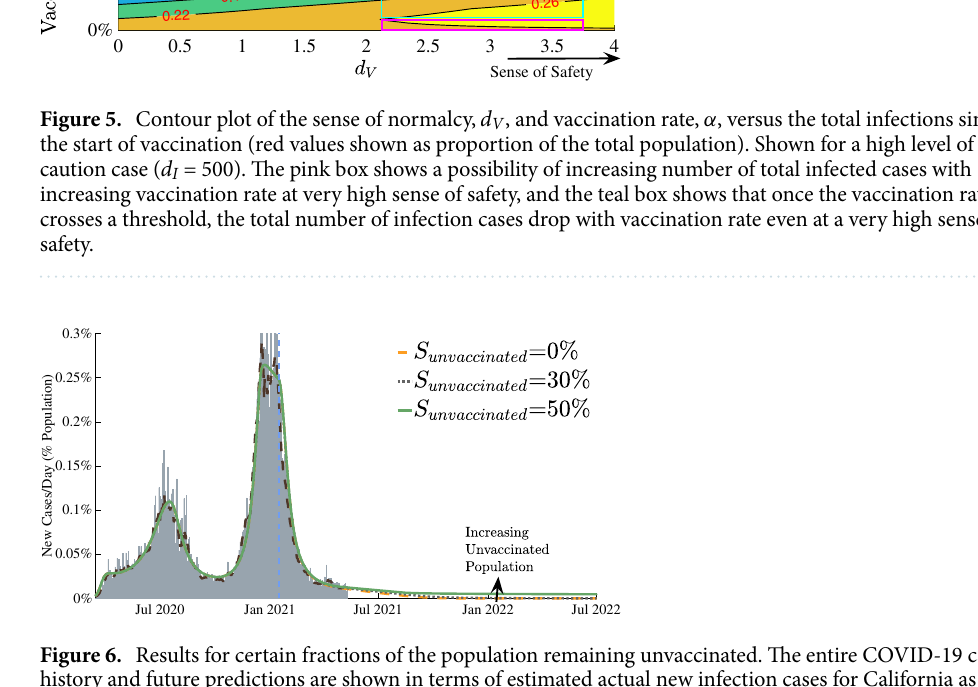
Figure 6. Results for certain fractions of the population remaining unvaccinated. The entire COVID-19 case history and future predictions are shown in terms of estimated actual new infection cases for California as a representative example. Gray bars represent the daily reports of new COVID-19 cases. The dashed brown lines are the corresponding 7-day average. Our model predictions for the entire duration are also shown as green, gray and yellow